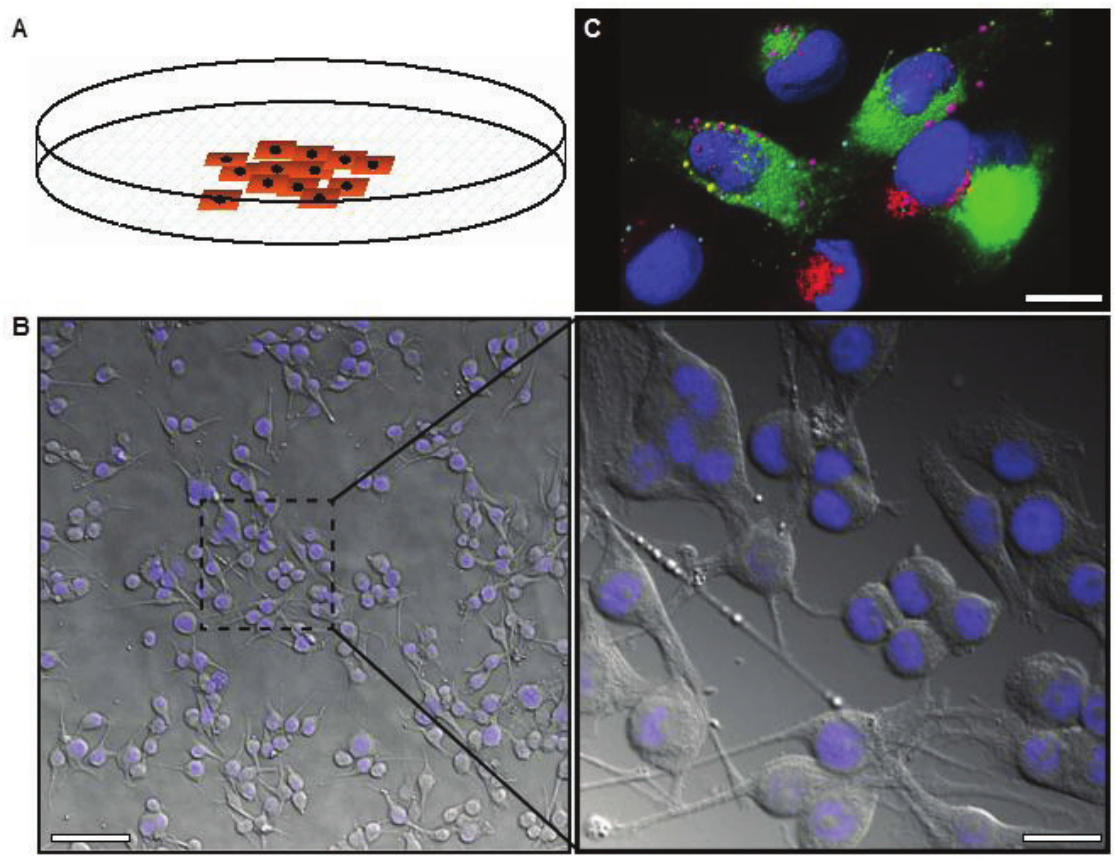
Figure 1. ( A ) Image showing two-dimensional cell growth in adherent cell culture in a plastic culture dish; ( B ) Differential interference contrast image overlaid with DAPI stain (nuclei, blue) demonstrating the morphology of melanoma cells in 2D culture, low and high magnification; ( C ) Deconvolved immunofluorescence image representing the highly complex internal structure of melanoma cells, labeled with markers for different endosomes or secretory vesicles (pink, red, or green) and the nucleus (blue). Scale